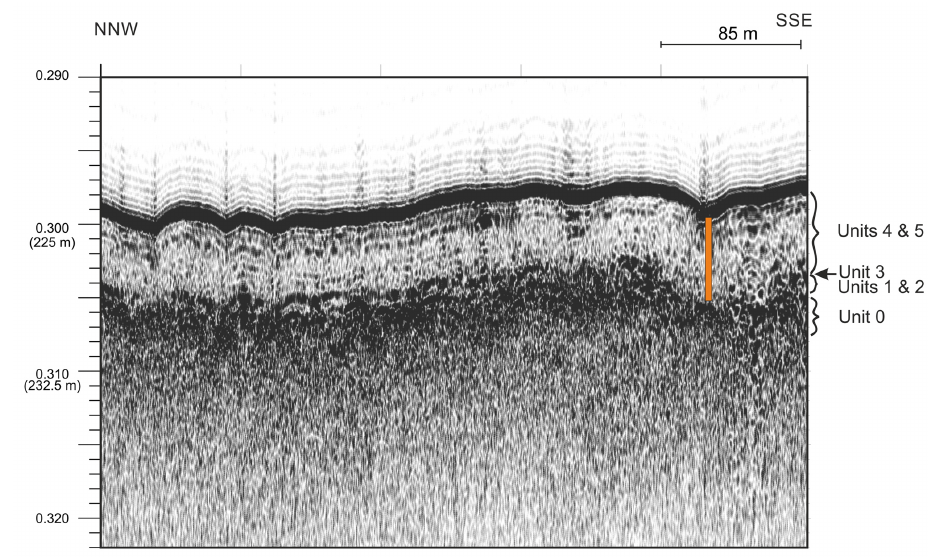
Figure 5. 3.5kHz chirp profile across the coring location. Core AMD14-Kane2b is represented by the orange box. Vertical scale in s (TWT) with depth conversion assuming 100ms (TWT) =